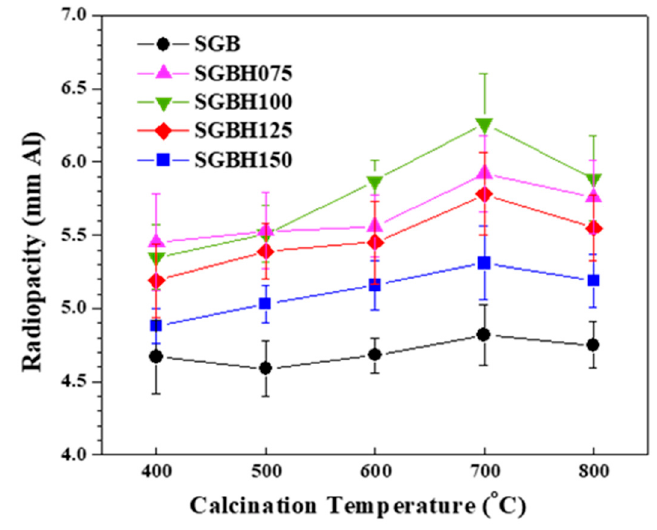
Figure 5. The radiopacity for MTA-like cements comprising various radiopacifiers of Bi/Hf (100/0) Bi/Hf (92.5/7.5) Bi/Hf (90/10) Bi/Hf (87.5/12.5) Bi/Hf (85/15) prepared from calcination temperature from 400 °C to 800 °C for 1 h. Table 2. Radiopacities of MTA-like cement prepared by sol-gelled powders. Radiopacities of Portland cement (PC) and PC with commercially available Bi 2 O 3 are 0.90 ± 0.15 and 4.56 ± 0.13 mmAl, respectively. Calcination Temp (°C)